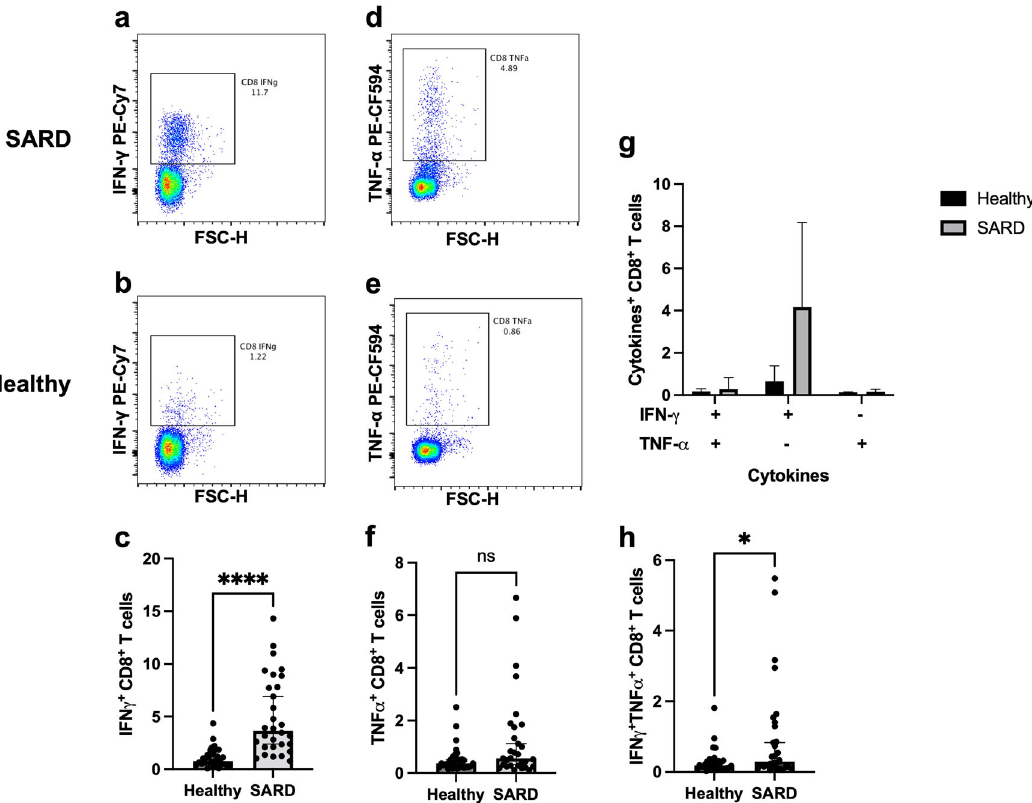
Fig. 5 Effector cytokine-producing CD8 + T cell responses in patients with systemic autoimmune rheumatic diseases and the healthy group. Patients with SARDs and the healthy group were vaccinated with CoronaVac followed by ChAdOx1 nCoV-19 (Oxford-AstraZeneca). Four weeks post-vaccination, blood samples were obtained and processed to obtain PBMCs. Frozen PBMCs were thawed and stimulated with S1 peptide pools. The blood samples were processed to obtain PBMCs. The cells were stained for surface T cell phenotypes and intracellular effector cytokines. Representative fl ow plots of IFN- γ producing CD8 + T cells in ( a ) patients with SARDs and ( b ) the healthy group ( c ) Percentage of IFN- γ producing CD8 + T cell responses. Representative fl ow plots of TNF- α producing CD8 + T cells in (d) patients with SARDs and ( e ) the healthy group ( f ) Percentage of TNF- α producing CD8 + T cell responses. ( g and h ) Percentages of IFN- γ and/or TNF- α secreting CD8 + T cells. Each symbol represents one participant and data are presented as the median with 95% CI. Statistical signi fi cance was determined using Mann – Whitney test between groups. * p ≤ 0.05, **** p ≤ 0.0001, ns nonsigni fi